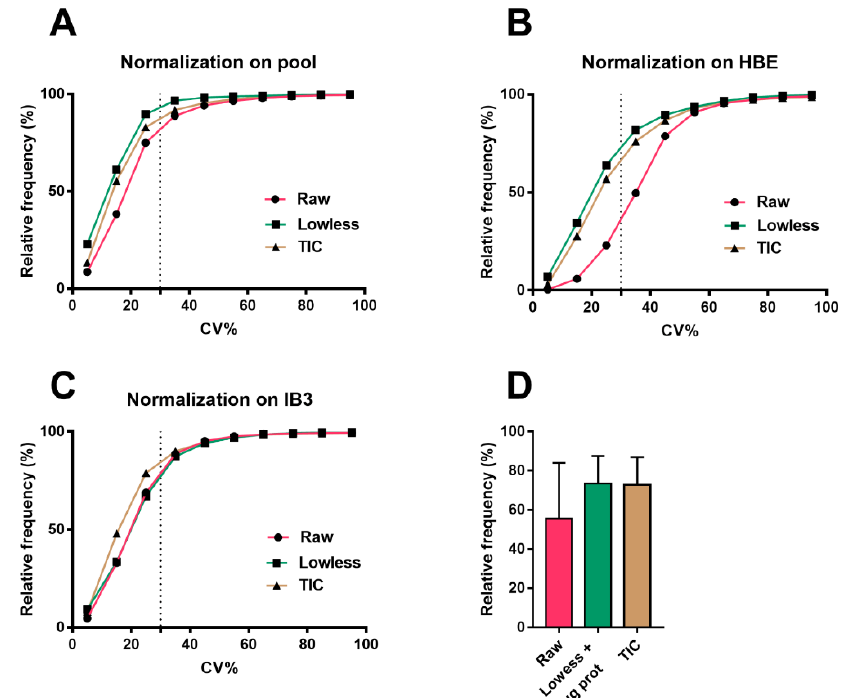
Figure 1. Cumulative frequency distribution of the coefficient of variations (CVs) (%) in ( A ) pool samples, ( B ) healthy HBE, and ( C ) cystic fibrosis (CF) cell extracts obtained for the precision evaluation of different normalization protocols comprehensive of results from both polarities. The dotted line indicates the separation between features within 30% of the CV, which is intended as the maximum permitted for the validation. The graphs showed the better performance of Lowess coupled to µg proteins as the normalization technique, reaching ( A ) 89%, ( B ) 64%, and ( C ) 68% in acceptable features (with a CV% inferior to 30%). ( D ) Graphs show the mean ± SD of the percentage of acceptable features (with a CV% inferior to 30%) between the different normalization techniques.